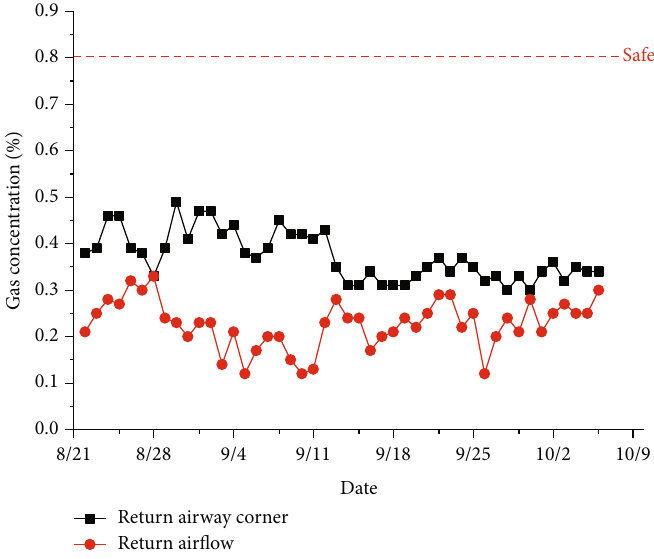
Figure 13: Return airway corner and return air fl ow gas concentration during mining.